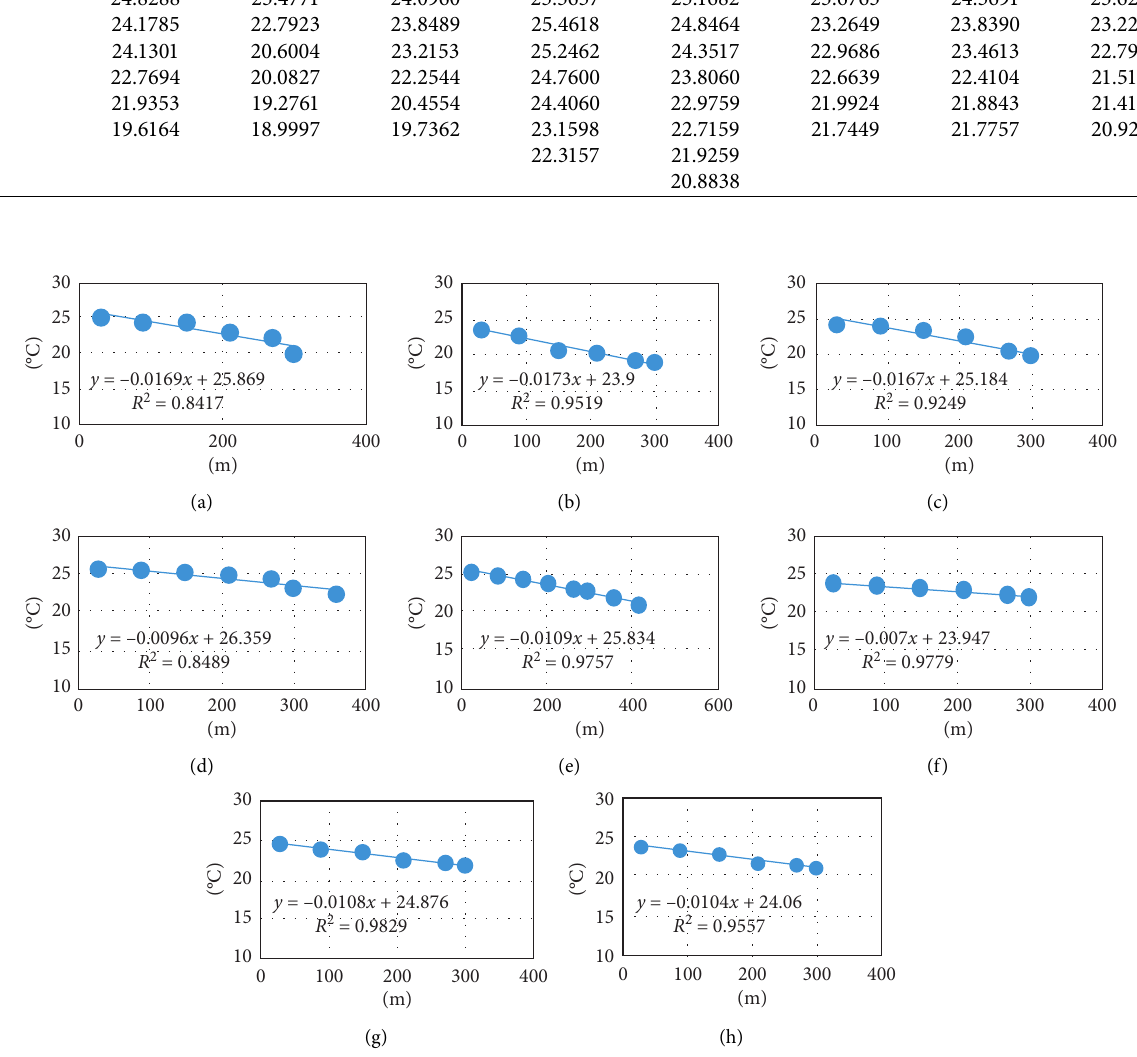
Figure 11: Temperature linear regression model of eight intersection points’